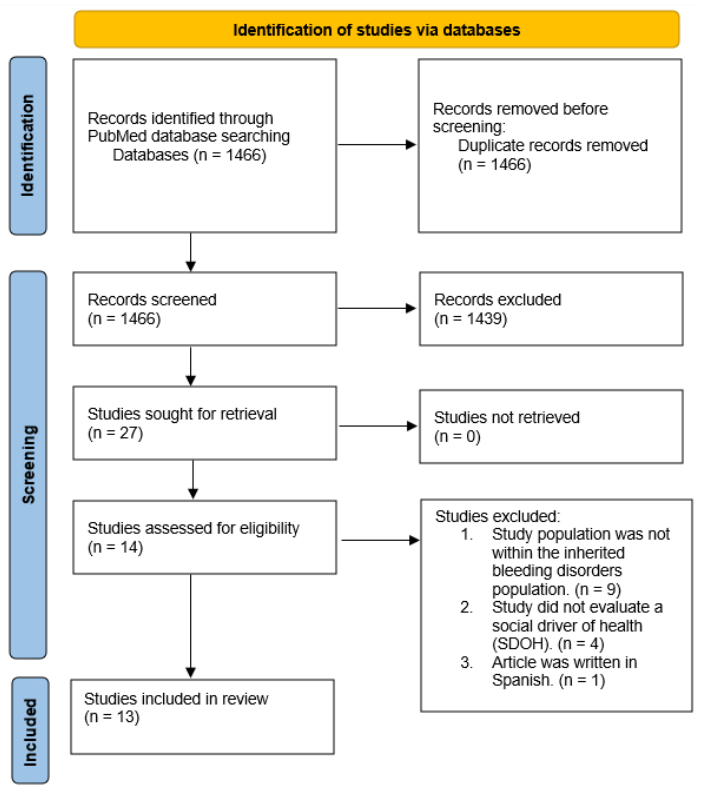
Figure 3. PRISMA flow diagram.